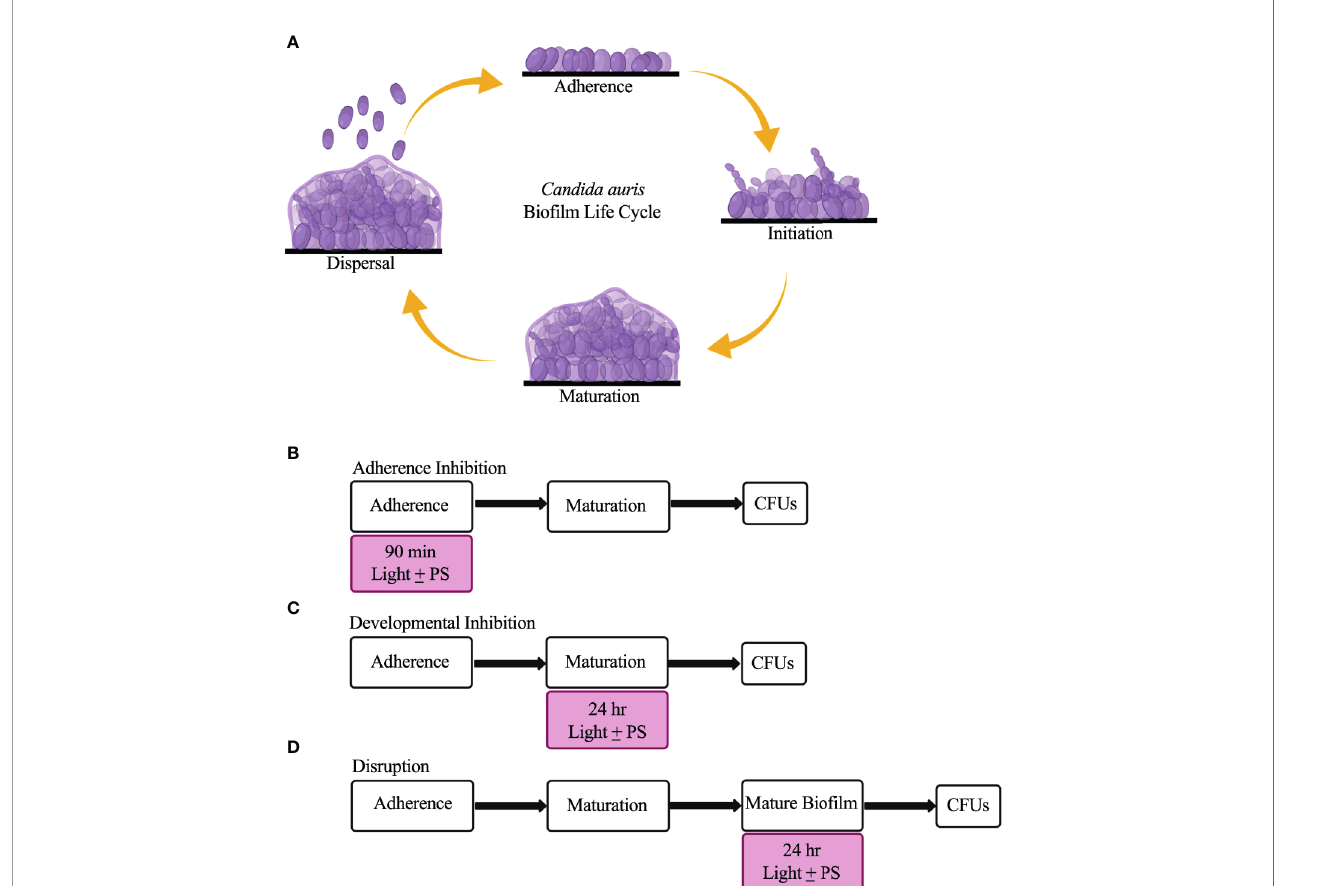
FIGURE 1 | The C . auris bio fi lm life cycle and the three bio fi lm assays used in this study to assess the effectiveness of visible lights with and without photosensitizing compounds. (A) The C . auris bio fi lm life cycle occurs in four stages: adherence, initiation, maturation, and dispersal. During the adherence stage, planktonic C . auris yeast-form cells adhere to a surface. During the initiation stage, the adhered cells proliferate, and some pseudohyphal cells are formed. During the maturation stage, the cells continue to proliferate and an extracellular matrix composed of glucans and mannans encases the bio fi lm cells. Finally, in the dispersal stage, yeast-form cells leave the bio fi lm to adhere to and form bio fi lms on new surfaces, or enter the bloodstream to cause systemic infections. (B) Overview of the adherence inhibition bio fi lm assay, where the visible light with (+) and without (-) the photosensitizing compound (PS) were present during the 90-min adherence stage of bio fi lm formation. (C) Overview of the developmental inhibition bio fi lm assay, where the visible light with (+) and without (-) the PS were present during the 24-h maturation stage of bio fi lm formation. (D) Overview of the disruption bio fi lm assay, where the visible light with (+) and without (-) the PS were present for an additional 24 h on a mature (24-h) bio fi lm. CFUs were measured to determine viable cell counts at the end of each bio fi lm assay. This fi gure was created using BioRender.com, and adapted from Bapat et al.,